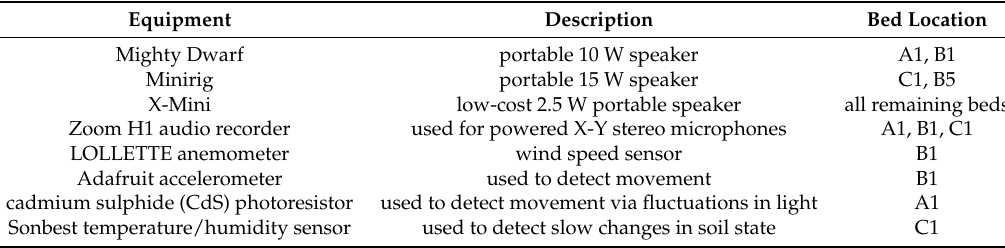
Table 1. Placement of sensors, microphones, and loudspeakers within the raised beds.